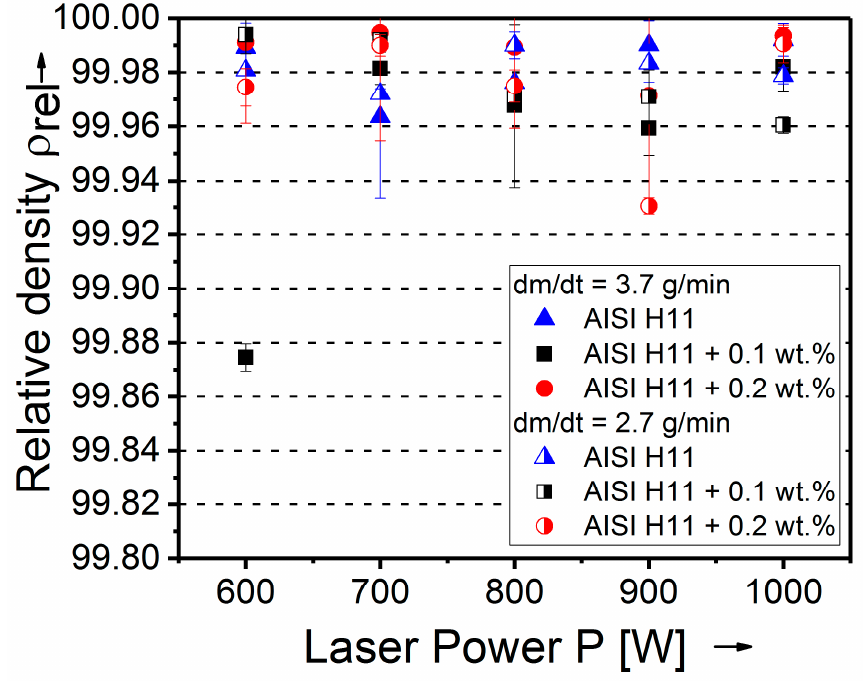
Figure A1. Relative density ρ rel of samples made out of pure AISI H11 and the modified powder mixtures as a function of laser power and with respect to the applied powder mass flow (determined on the basis of three analyzed planes per sample).